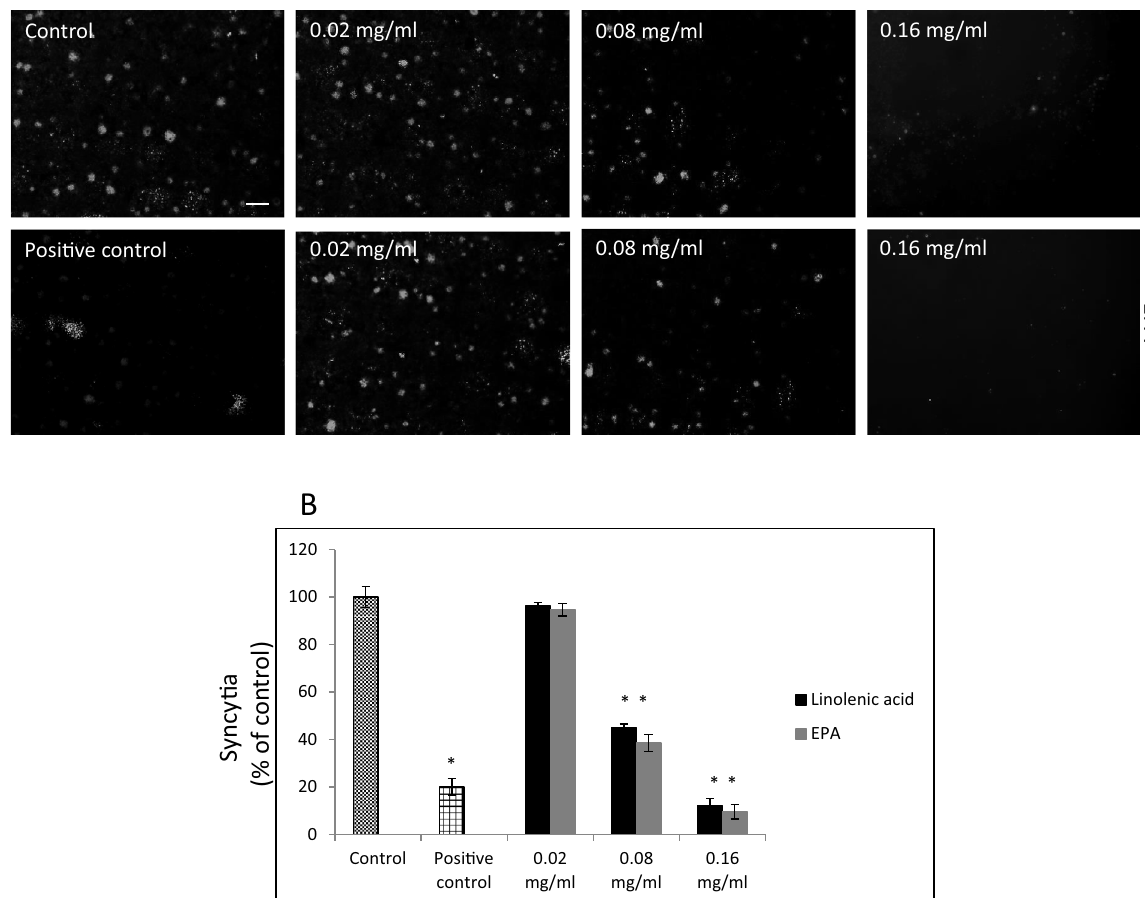
Figure 5. Effect of selected FAs on fusion to human ACE2 receptor overexpressing A549 cells. ( A ). Cell–cell fusion of A549 cells expressing eGFP spike protein with A549 cells stably expressing human ACE2 receptor. A549 cells expressing eGFP spike protein were pre-treated with indicated FAs at different concentrations for 1 h at 37 °C and co-cultured for additional 4 h at 37 °C with A549 cells stable expressing human ACE2 receptor. The scale bar indicates 250 µm. ( B ) Quantitative analysis of formed syncytia. Experiments were done in triplicate and repeated three times. Data are presented as % of control ± SD; * p ≤ 0.001. Control—0.025% DMSO, positive control—20 μg/ml anti-ACE2